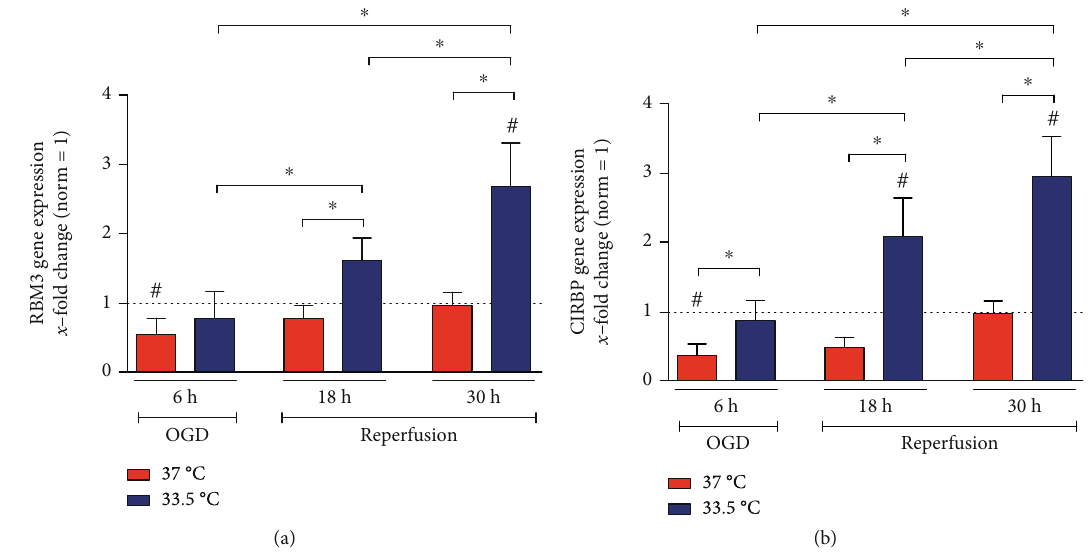
Figure 5: RT-qPCR gene expression analysis of the cold-inducible RNA binding proteins (a) RBM3 and (b) CIRBP after exposure to 6 hours OGD followed by 12 and 24 hours reperfusion (18 hours and 30 hours after experimental start, respectively) at 37 ° C and 33.5 ° C. Data from at least 3 independent experiments are shown as mean ± SD . Statistical analysis was performed using one-way ANOVA with Tukey posttest; # p < 0 : 05 as compared to 37 ° C normoxia control group and ∗ p < 0 : 05 comparison between the two experimental groups were considered signi fi